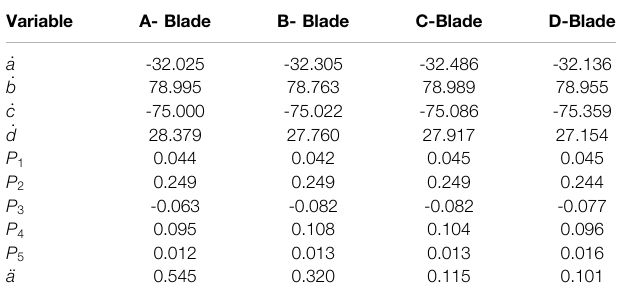
TABLE 3 | The variable design results after two-objective